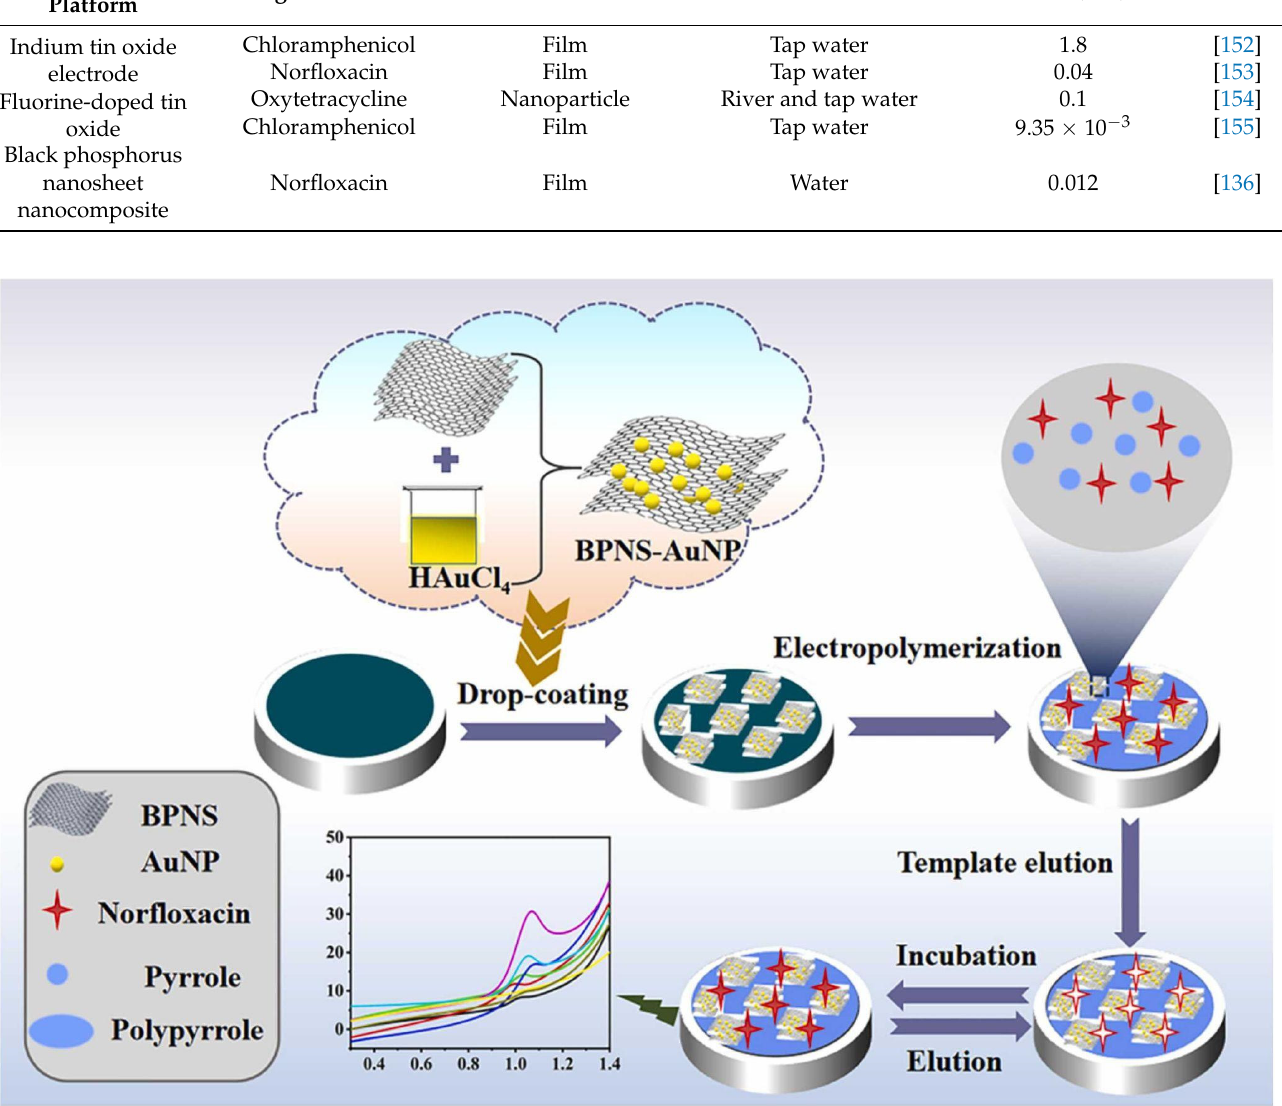
Figure 4. Fabrication of MIP-black phosphorus nanosheet nanocomposite on GCE (MIP/BPNS- AuNP/GCE) for sensitive determination of norfloxacin (NOR). Reprinted with permission from [136]. Copyright 2022 American Chemical Society. Table 4. Antibiotic MIPs combined with electrochemical label-free sensor platforms and their per- formance.